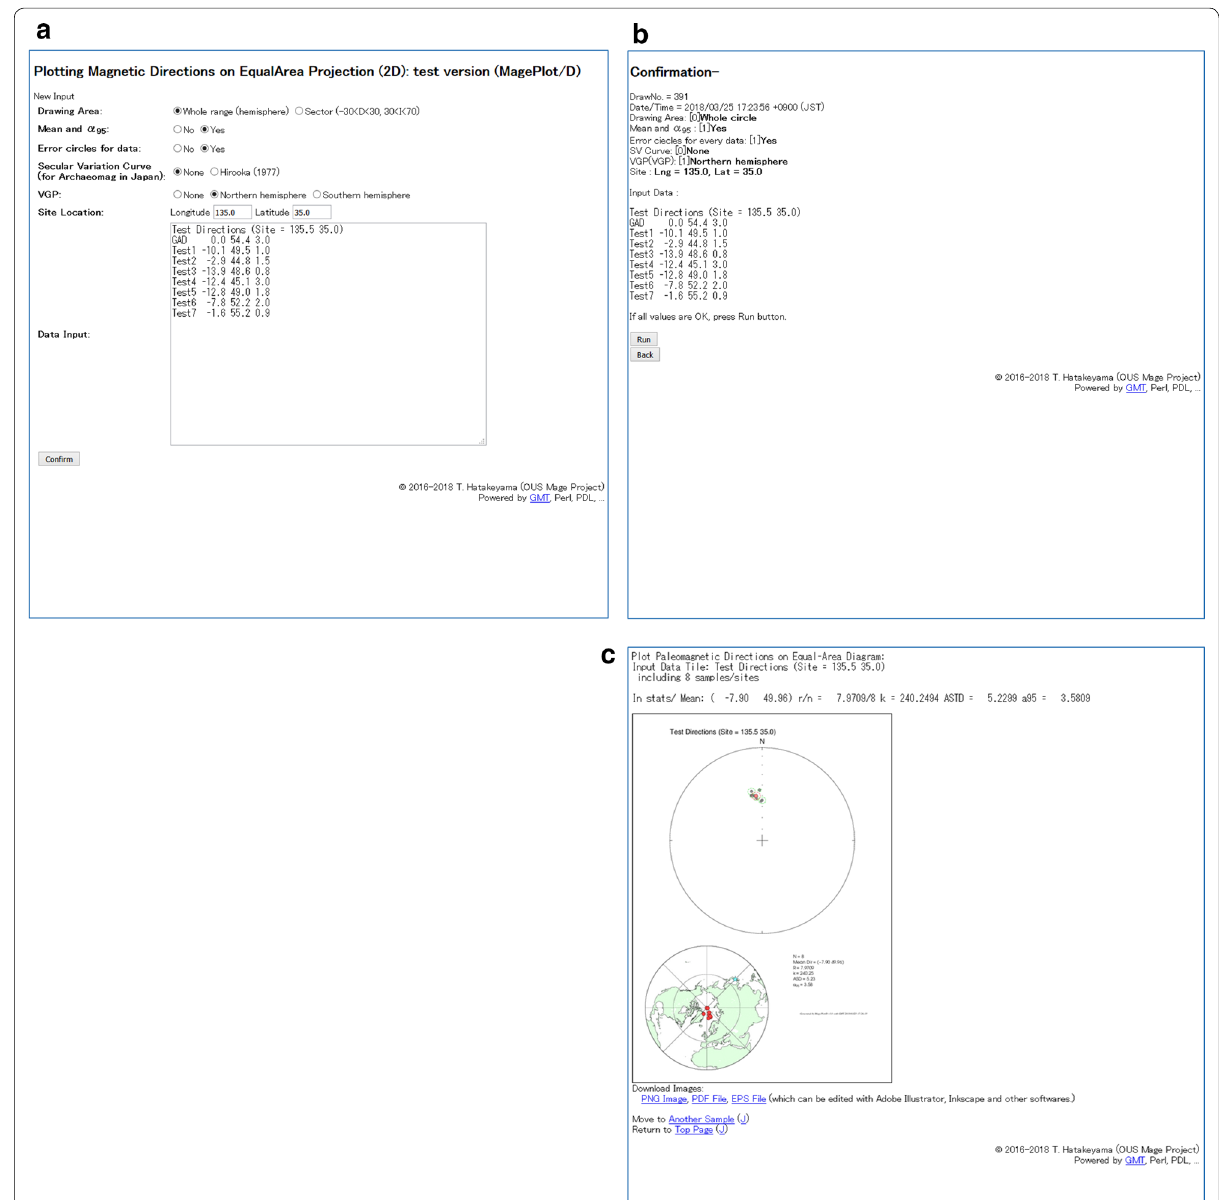
Fig. 3 Screenshots illustrating the use of the MagePlot/D service: a data and options input window, b confirmation window, and c results window. In this example, the option to show a VGP display in the Northern Hemisphere was